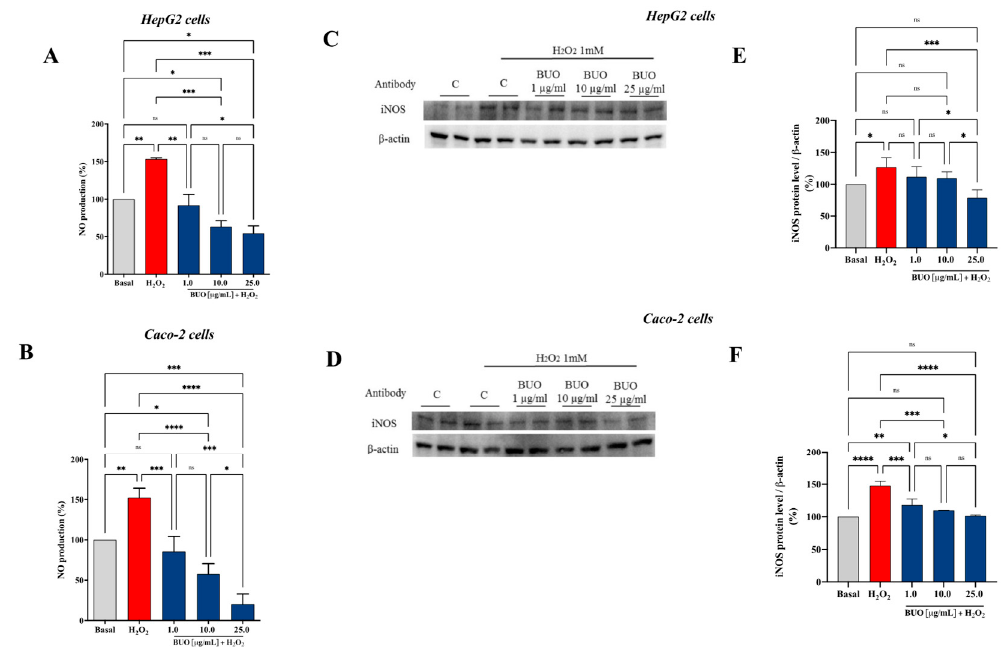
Figure 5. Effect of the BUO extract on the H 2 O 2 (1 mM)-induced NO levels ( A , B ) and inducible nitric oxide synthase (iNOS) protein levels ( C – F ) in human hepatic HepG2 cells (A,C,E) and intestinal Caco-2 cells (B,D,F). The data points represent the averages ± SD of six independent experiments in duplicate. All data sets were analyzed by One-way ANOVA followed by Tukey’s post-hoc test. ns: not significant; (*) p < 0.5, (**) p < 0.01, (***) p < 0.001, (****) p < 0.0001. Basal: untreated cells.